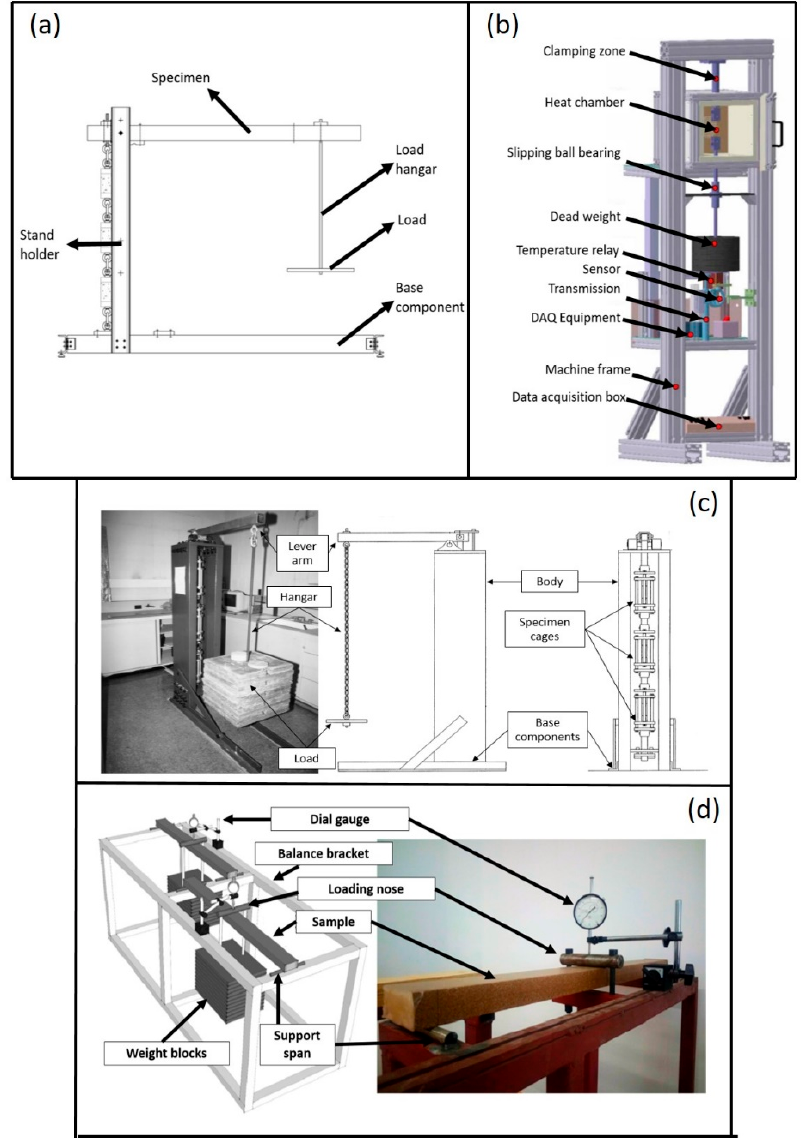
Figure 12. Schematic and overall creep test rig: ( a ) cantilever beam; ( b ) tensile mode; ( c ) compression mode; and ( d ) flexural mode.